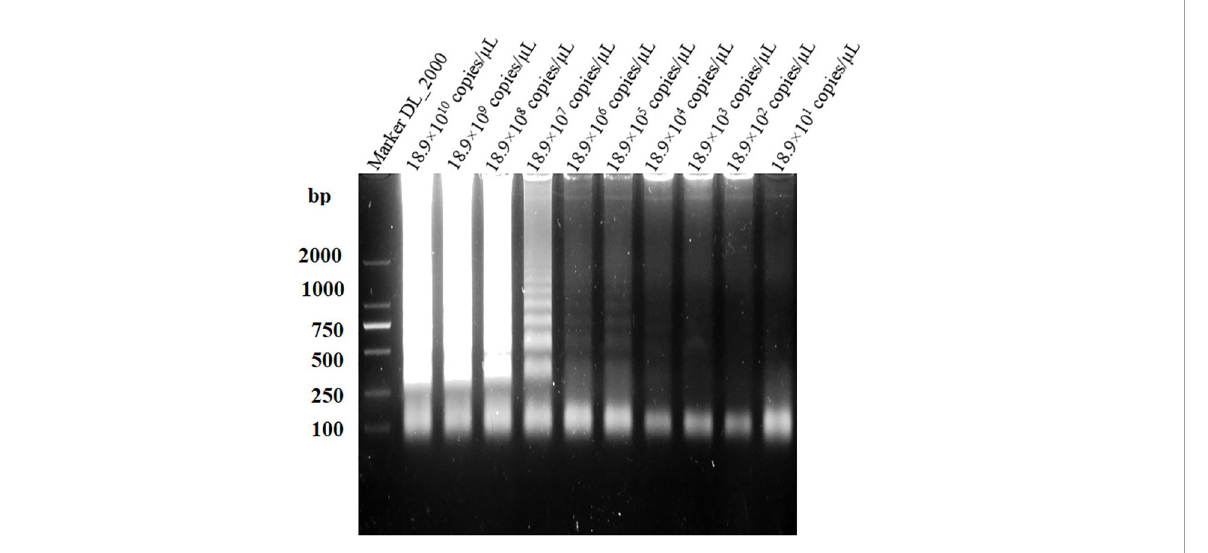
FIGURE 5 Lower limit of detection of the LAMP assay for the detect ion of Brucella suis S2 vaccine strain. Assay products were visualized using gel